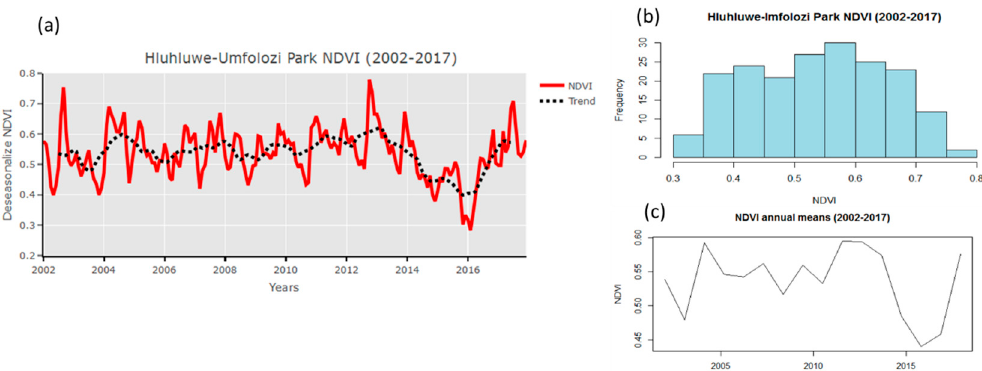
Figure 4. ( a ) The deseasonalized monthly mean NDVI time series for HiP. The continuous red line indicates the trend estimate and the dashed red lines show the 95% confidence interval for the trend based on resampling methods. ( b , c ) show the histogram and yearly mean time series, respectively.